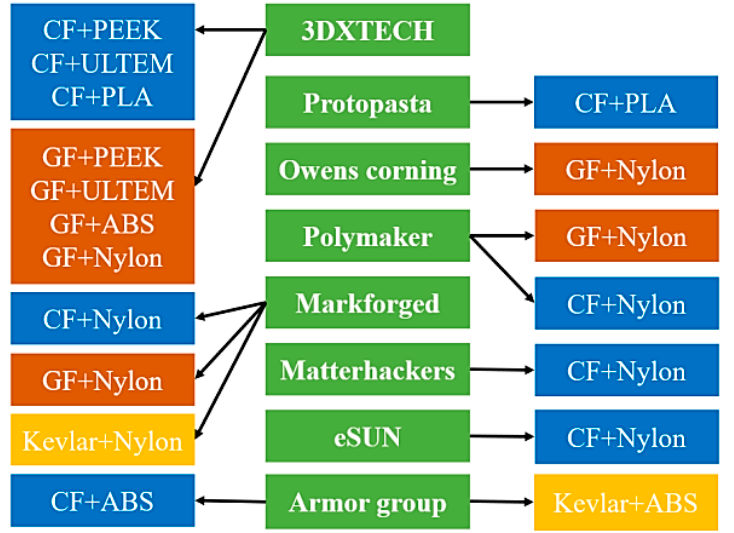
Figure 12. Manufacturers of FDM filament and printer (middle column) and their associated fiber-reinforced composite products. Key fibers reinforcements include carbon fiber (CF), glass fiber (GF) and Kevlar (KF), while popular matrixes are nylon, polylactic acid (PLA), PEEK, and acrylonitrile butadiene styrene (ABS) [96].